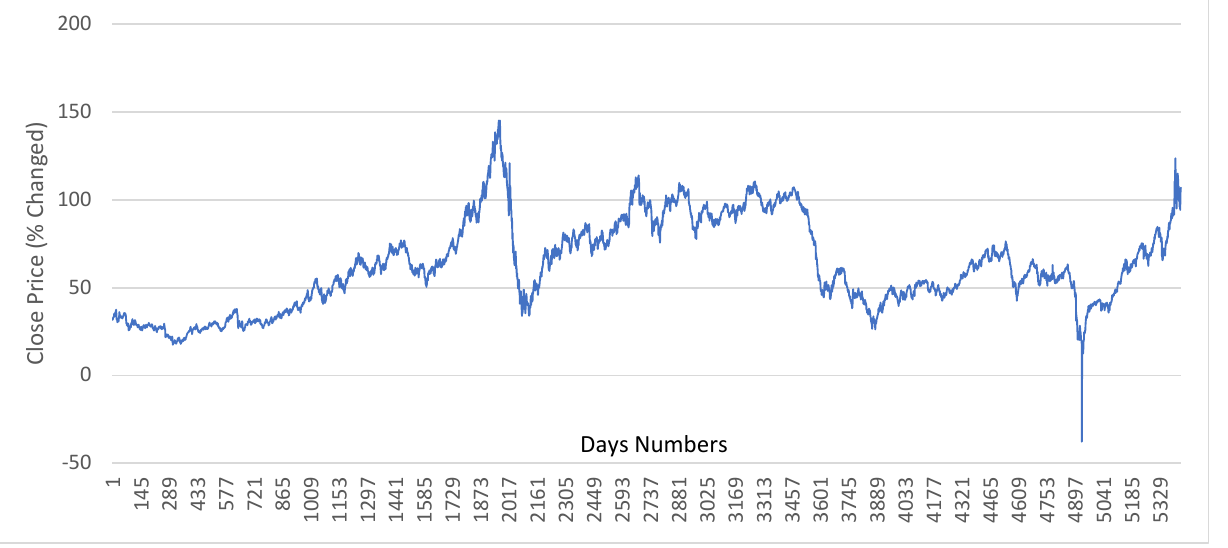
Figure 2. Crude oil closing price graph.